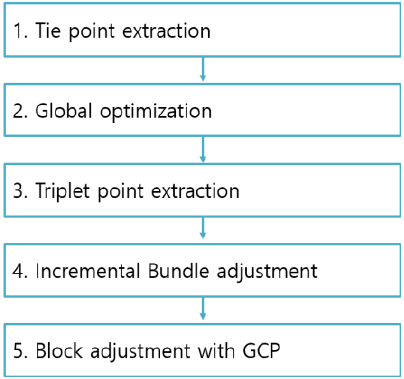
Figure 1. Flow chart for the operation that includes incremental bundle